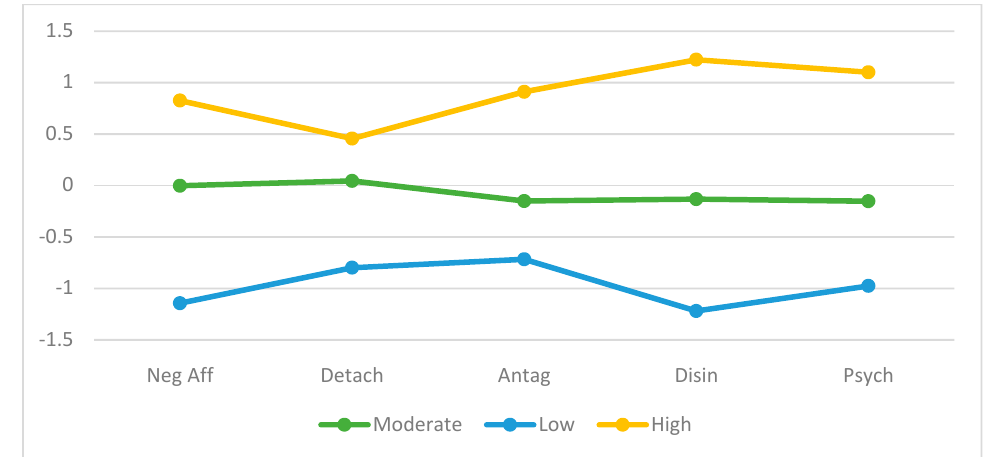
Figure 2. Pro fi le plot for Pathological Personality Traits with AMPD-Only Pro fi les. Note. Figure 2. Profile plot for Pathological Personality Traits with AMPD-Only Profiles. Note. Standardized Standardized mean scores (M = 0, SD = 1) of the Alternative Model of Personality across mean scores (M = 0, SD = 1) of the Alternative Model of Personality across three three pro fi les.